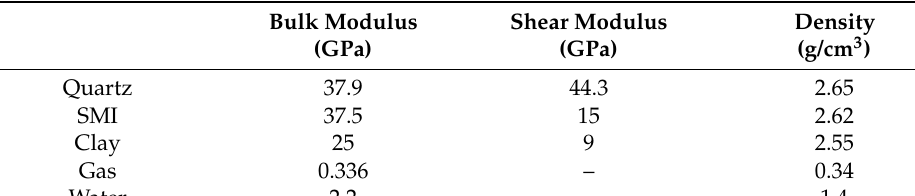
Figure 2. The logging curve and mineral composition information of the reference well section.